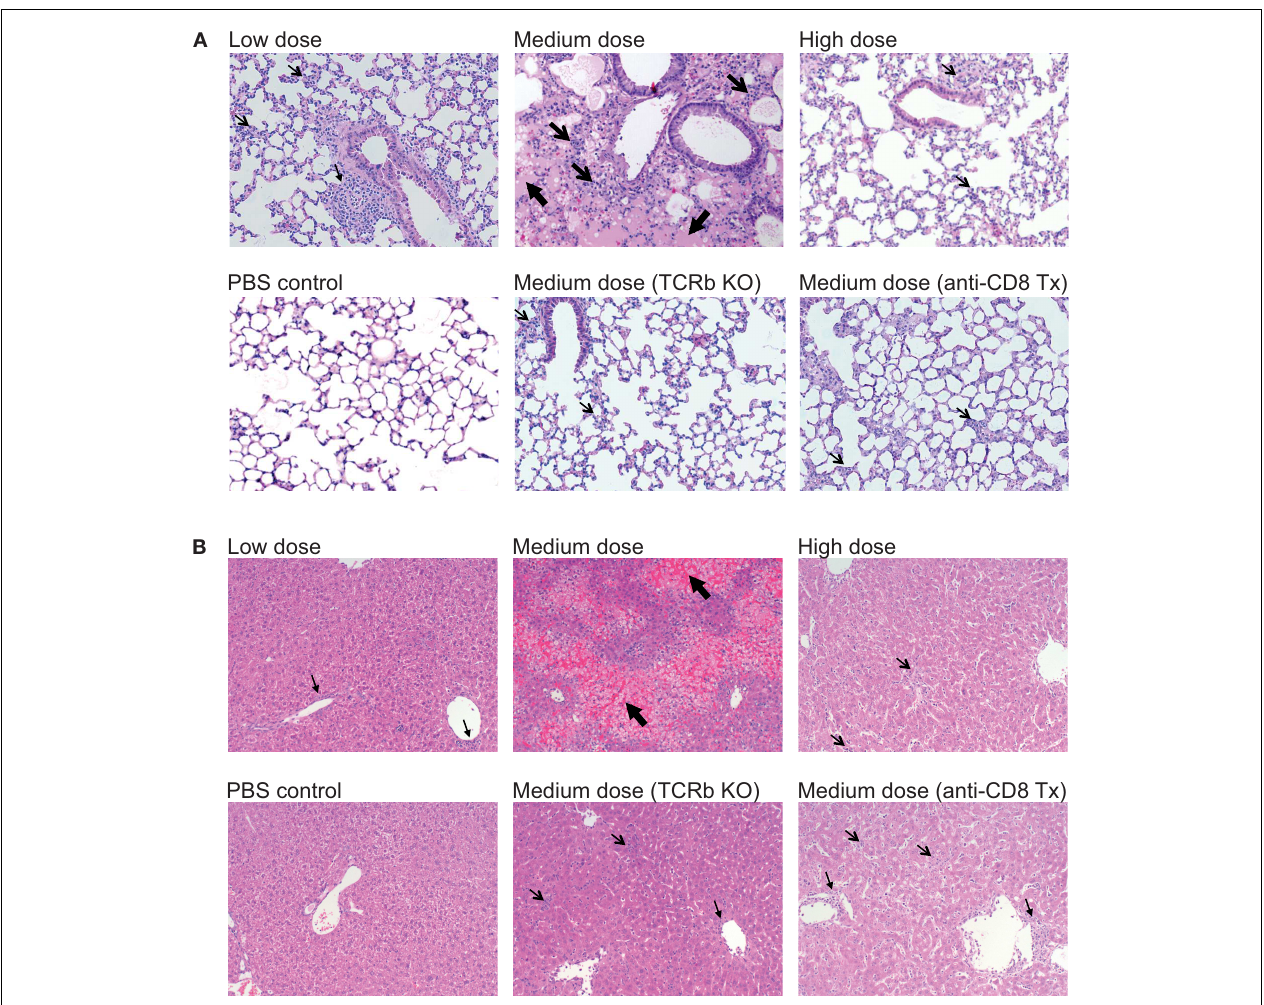
depleted of CD8T cells with anti-CD8 mAb orTCR β KO mice were protected from severe lung pathology having only minimal interstitial infiltrates. (B) Histological sections of the liver (H&E stain) showed serious bridging necrosis in the medium dose LCMV clone 13-infected mice at day 13, while the high and low dose mice as well as theTCR β KO and CD8 depleted medium dose mice had only periportal and sinusoidal inflammatory infiltrates. Arrows indicate the areas of significant